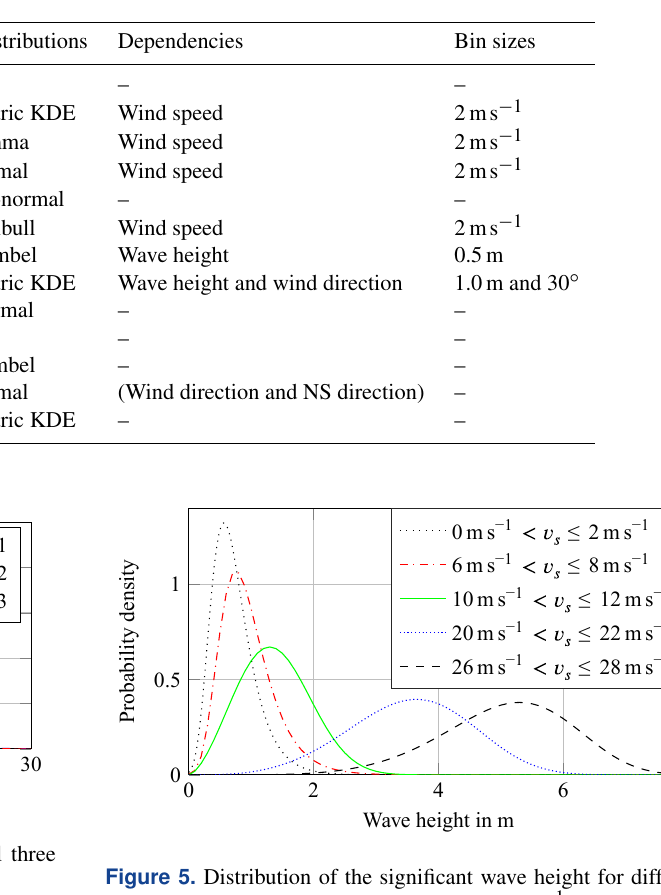
Table 2. Dependencies, statistical distributions, and bin widths for environmental conditions derived from FINO1–3 data.